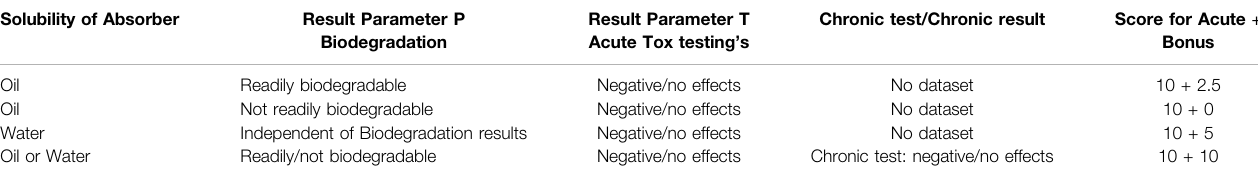
TABLE 2 | Overview of speci fi c data set situations to take solubility and incomplete OECD datasets into account. Solubility of